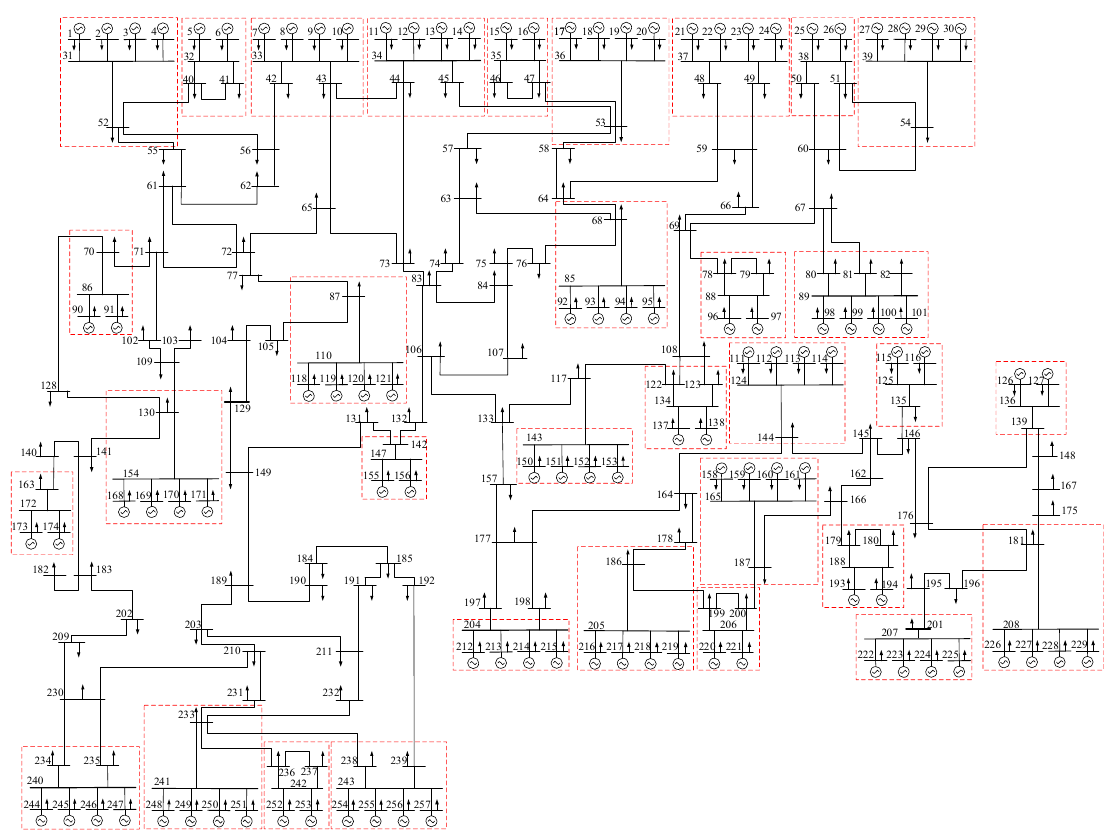
Figure 6. Online diagram of the example power system in East China.